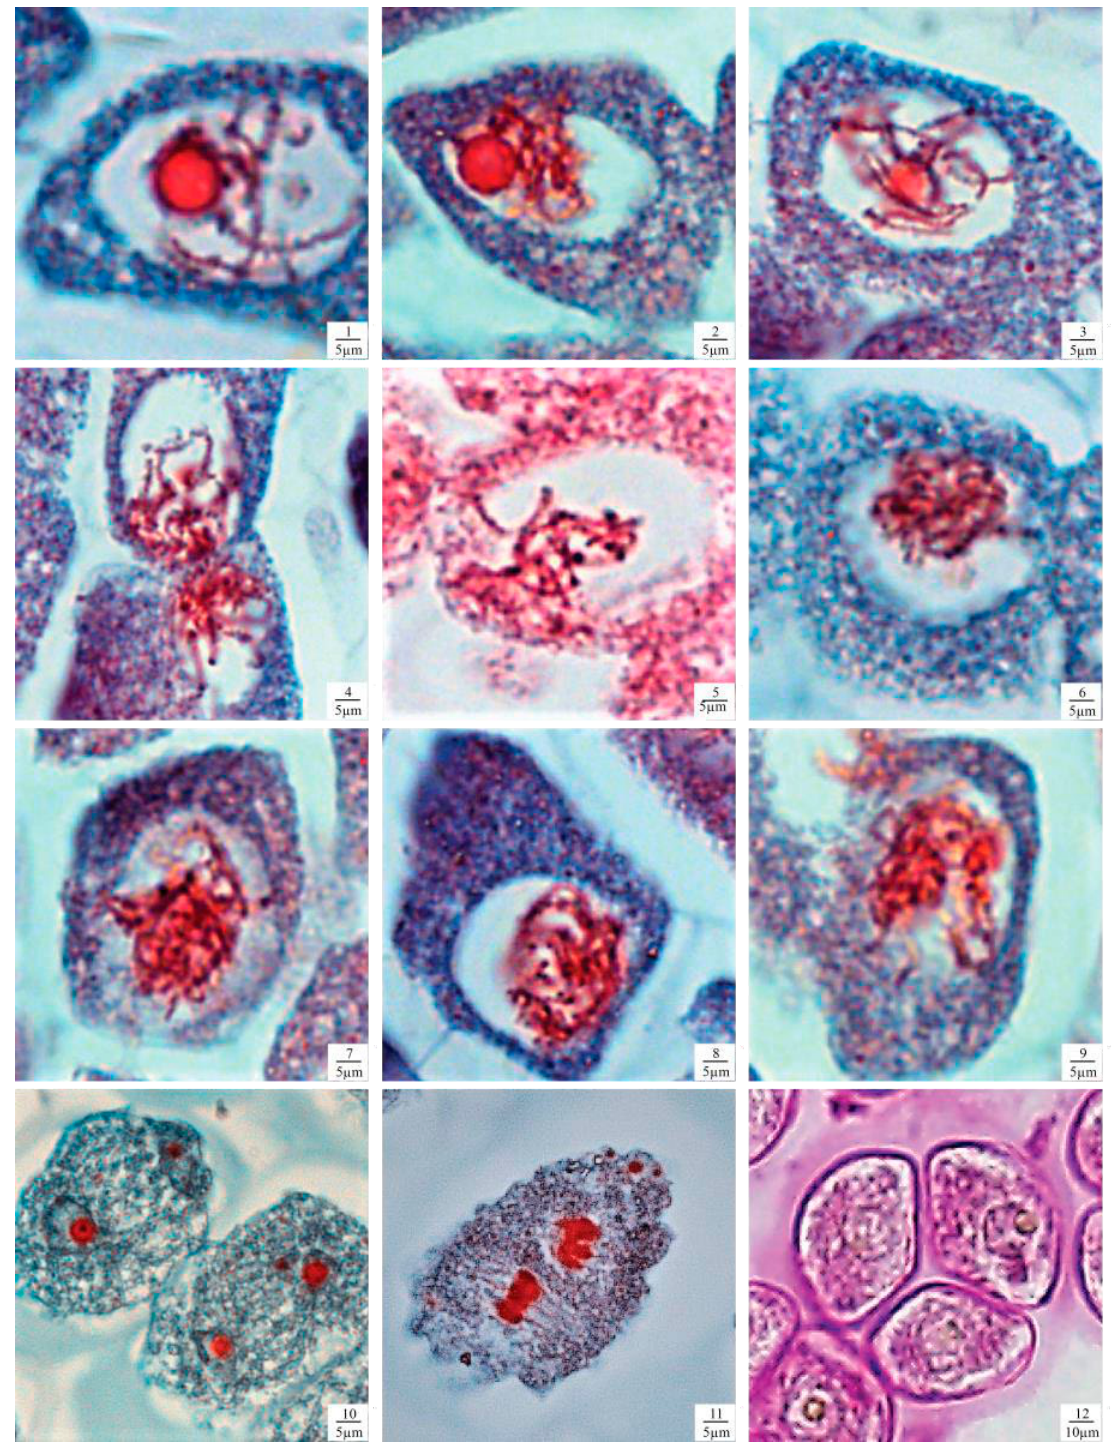
Figure 4. Male gametophyte development of pecan. 1) Microspore mother cells separating and detaching from each other. 2) Pre-prophase, leptonema I, chromosome extraction. 3) Zygotene I, nucleolus gradually disappearing. 4) Pachytene I, chromosomes shorter and thicker, relatively concentrated. 5) Diplotene I, chromosome pairing; Figure 4-6. Metaphase I (polar view). 7) Metaphase I (side view). 8-9) Ana- phase I, chromosomes at poles. 10) Dyad, visible binucleated cells. 11) Metaphase II, spindle apparatus. 12) Tetrad stage of microspore